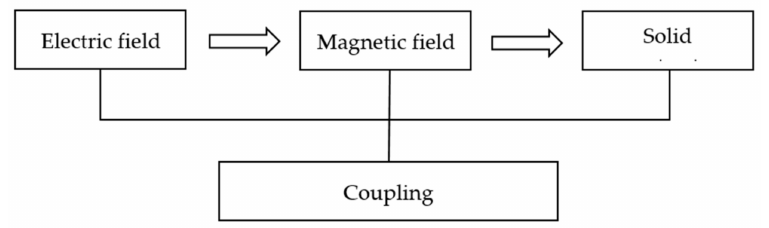
Figure 4. Separated coupling